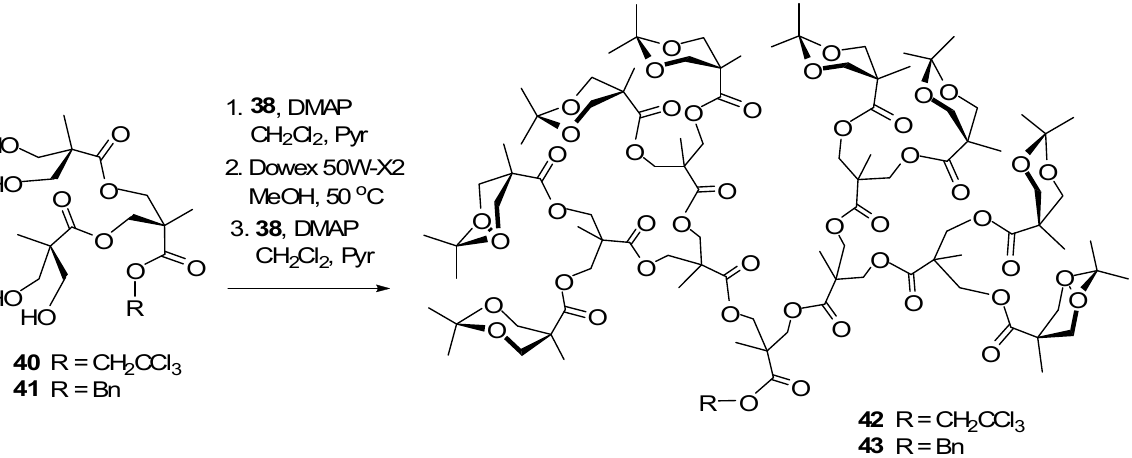
Scheme 23. Preparation of protected fourth generation dendrons